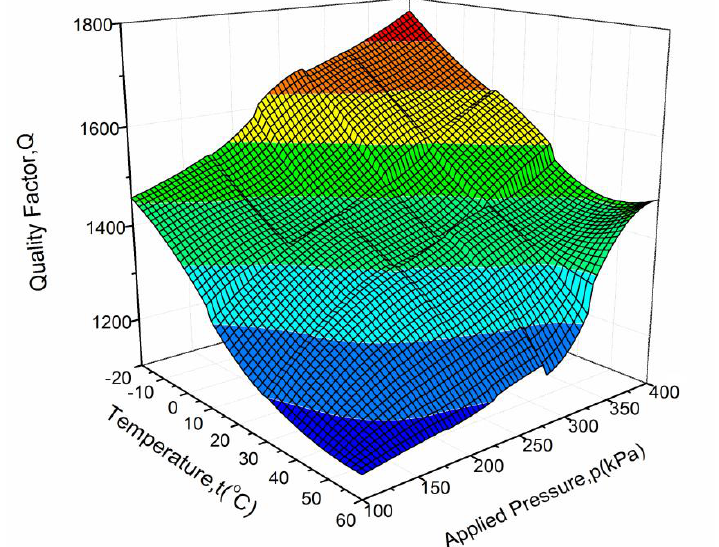
Figure 12. The variation of Q-factor with applied pressure and ambient